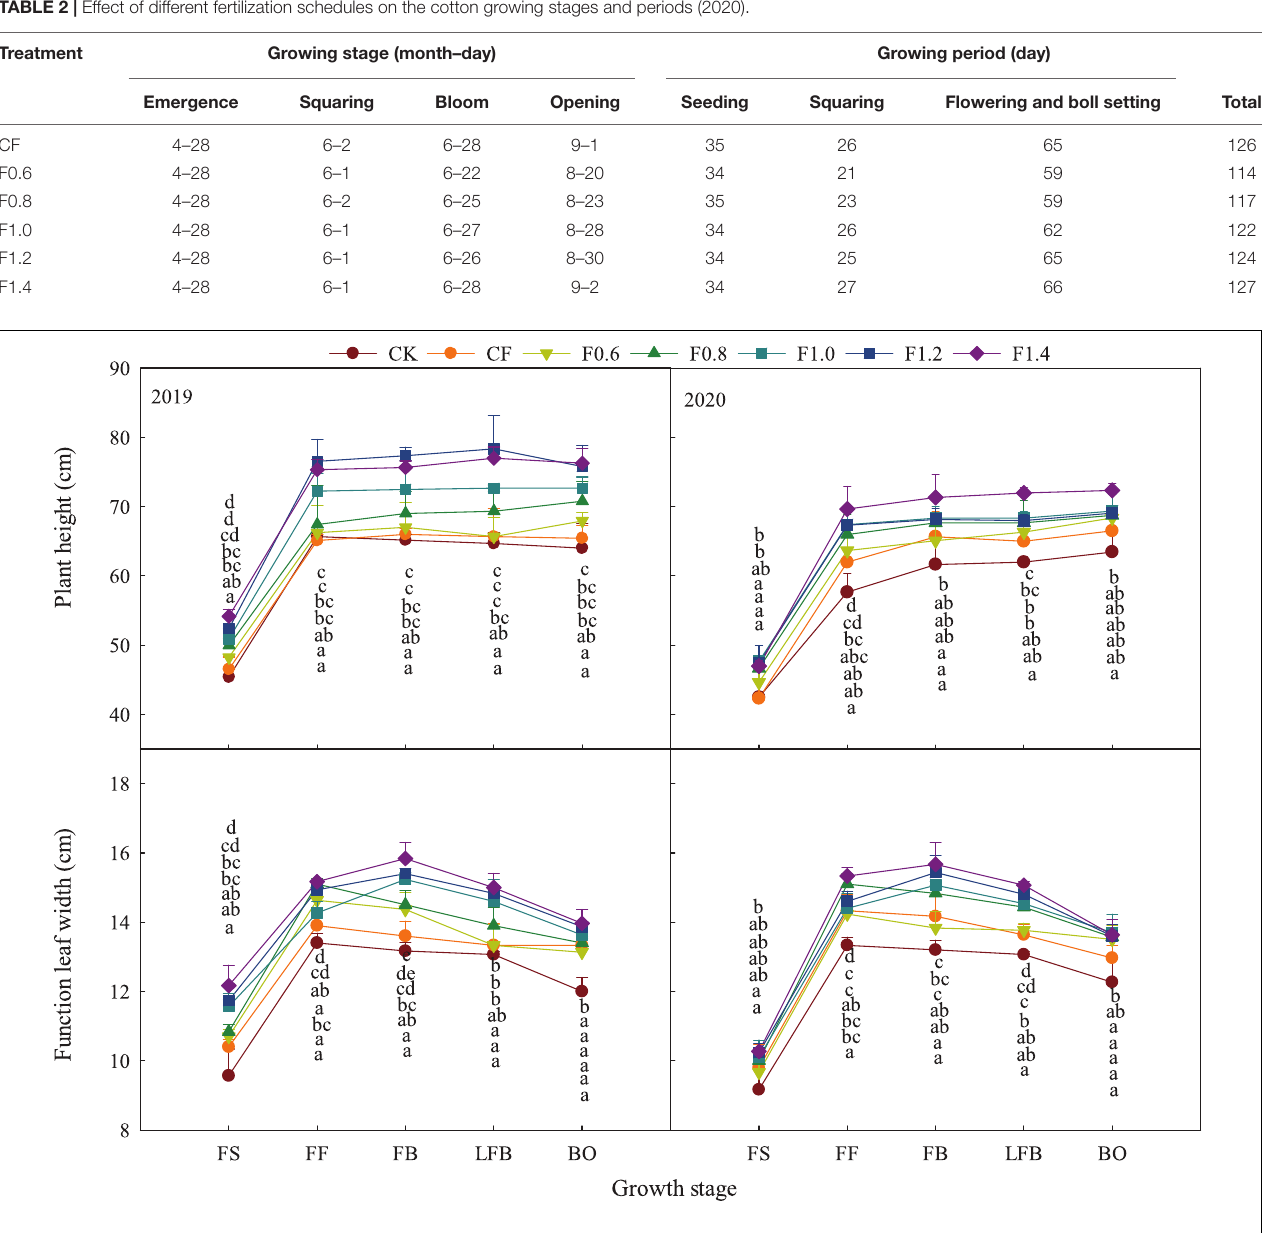
FIGURE 3 | The changes of cotton plant height and functional leaf width in different fertilization treatments. FS, full squaring stage; FF, full flowering stage; FB, full boll stage; LFB, later full boll stage; BO, boll opening stage. Different letters above the adjacent seven columns indicate statistical significance at the P = 0.05